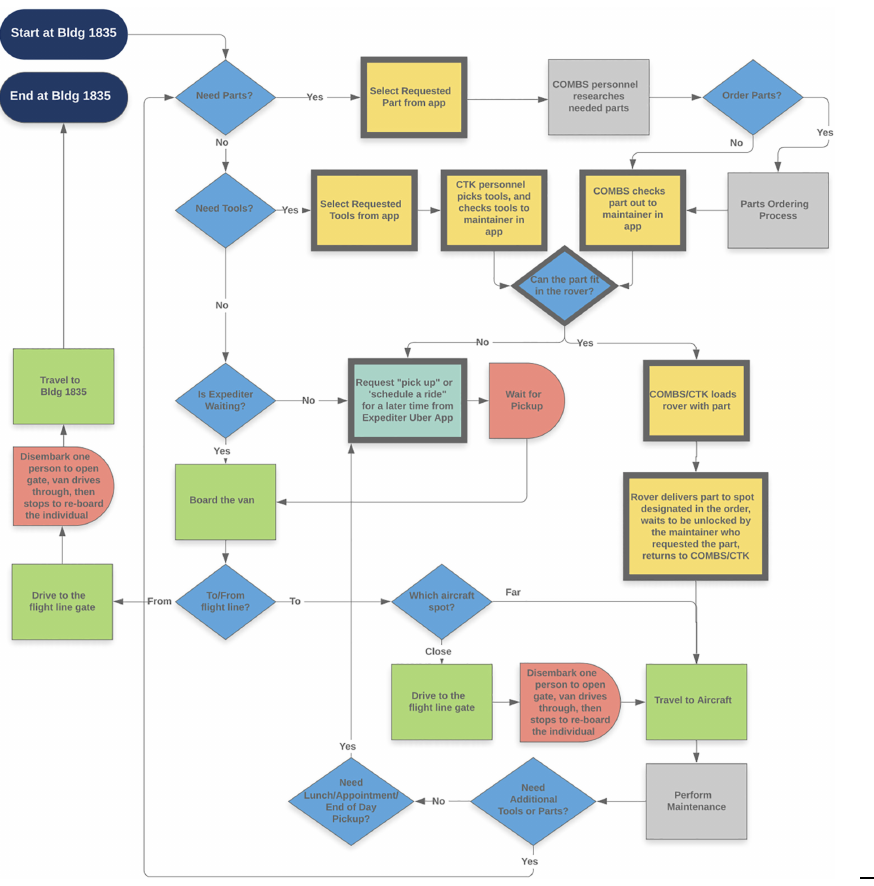
Figure 5. Proposed